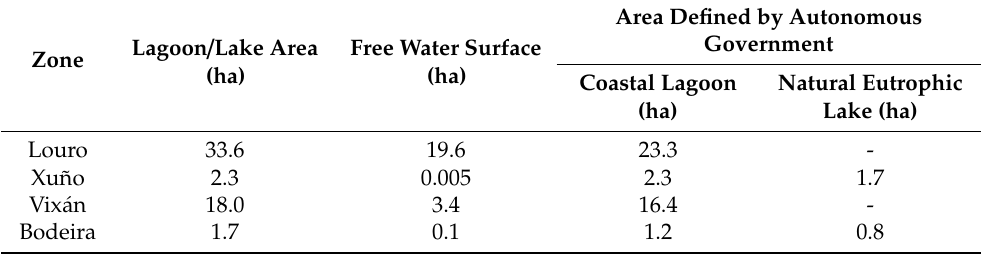
Table 3. Estimated surface in each sector follow our delimitation for the case of the second and third column and employed the surface values included in Annex I of PDRN over the interest zone for this study in the columns defined as “Area defined by autonomous government”.